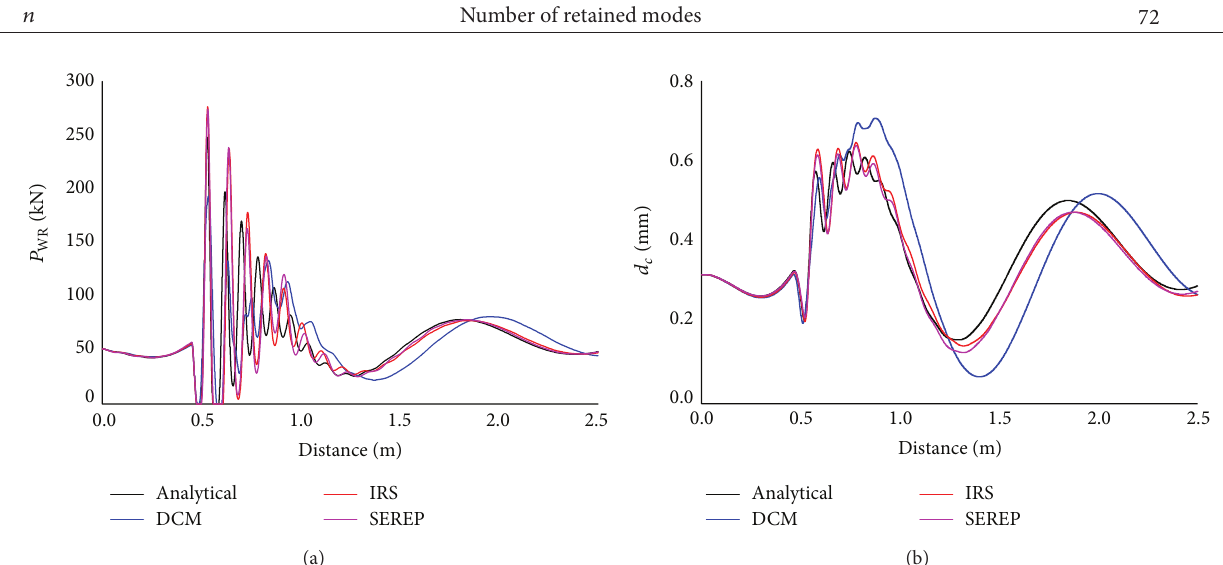
and (b) rail deflection at the contact point 𝑑 𝑐 predicted by the proposed condensed WR